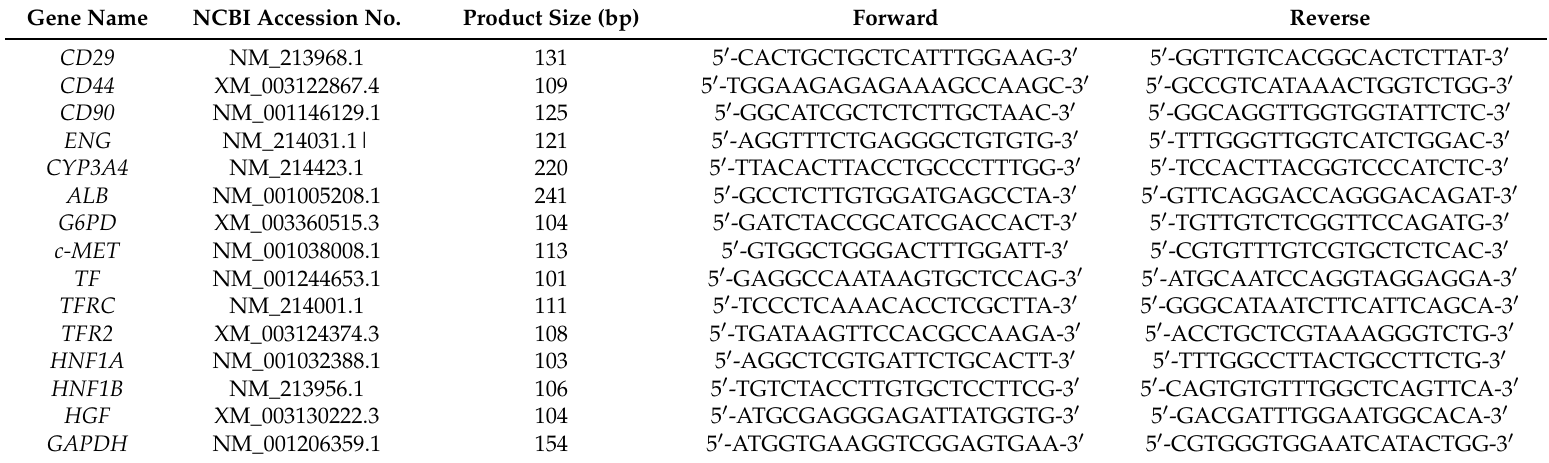
Table 1. Primers for